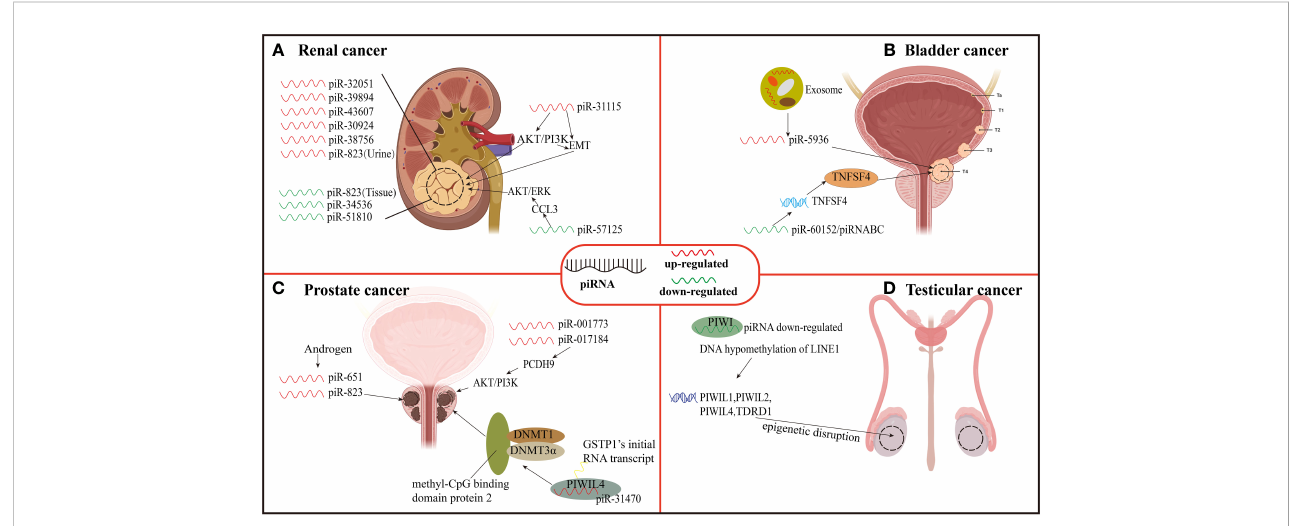
FIGURE 3 Expression and function of piRNAs in urinary neoplasms. (A) Renal carcinoma. (B) Bladder cancer. (C) Prostate cancer. (D) Testicular